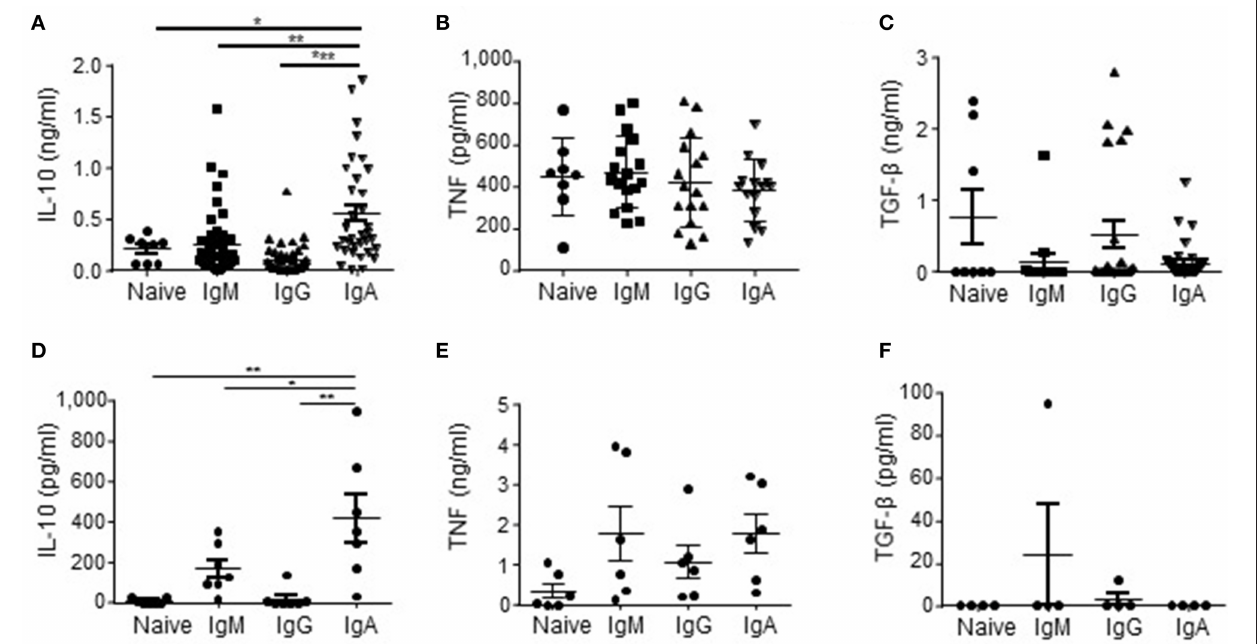
FIGURE 1 | IL-10 is preferentially produced by human IgA + B cells. (A–C) In order to rest the B cells, naïve (CD19 + IgD + CD27 − ; n = 8), IgM (CD19 + CD27 + IgM + ; n = 45), IgG (CD19 + CD27 + IgG + ; n = 41), and IgA (CD19 + CD27 + IgA + ; n = 35) human B cell clones were cultured for 48h in IMDM supplemented with 10% FCS in the absence of CD40L-expressing fibroblasts and IL-21. In the final 5h of the culture PMA/IO was added, where after supernatants were harvested and analyzed for the presence of IL-10 (A) , TNF (B) , and TGF- β (C) using ELISA. Each dot represents an individual B cell clone derived from peripheral blood of two healthy donors. (D–F) Freshly isolated peripheral blood-derived naïve (CD19 + IgD + CD27 − ), IgM (CD19 + CD27 + IgM + ), IgG (CD19 + CD27 + IgG + ), and IgA (CD19 + CD27 + IgA + ) human B cells were cultured for 16h in IMDM containing 10% FCS. In the final 5h of the culture PMA/IO was added, where after supernatants were harvested and analyzed for the presence of IL-10 (D) , TNF (E) and TGF- β (F) using ELISA. Data are shown for n = 7 healthy donors (D) , n = 6 donors (E) and n = 4 donors (F) . Mean ± SD are shown. * P < 0.05, ** P < 0.01, and *** P < 0.001 (one-way ANOVA with Bonferroni multiple comparison